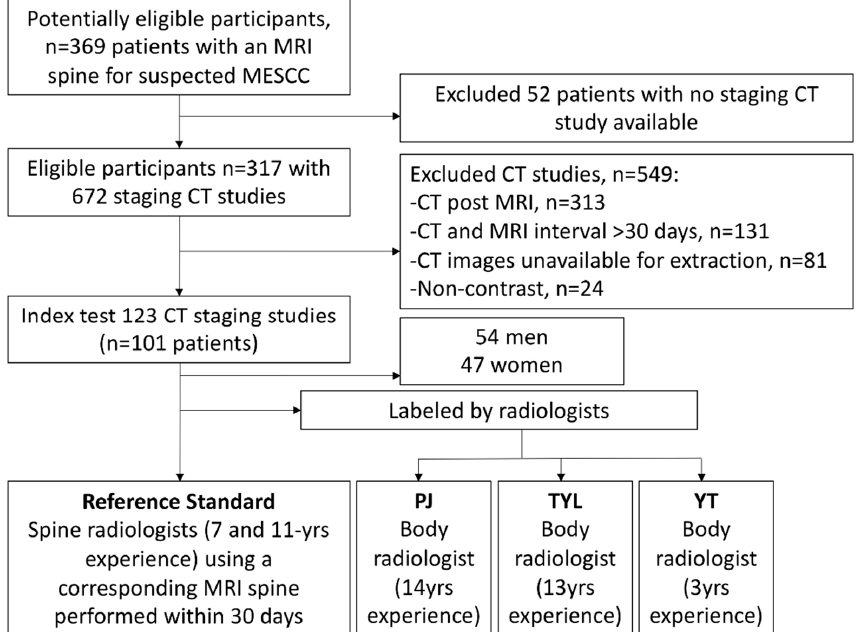
Figure 2. Flow chart demonstrating the overall study design with inclusions and exclusions high- lighted. MESCC = Metastatic epidural spinal cord compression.